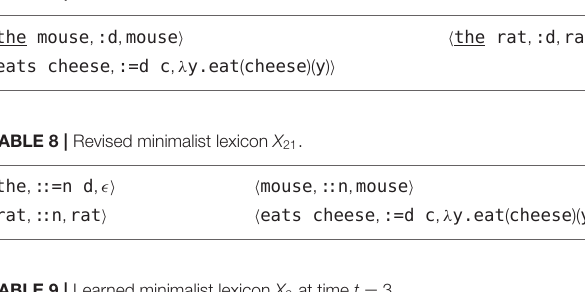
TABLE 7 | Learned minimalist lexicon X 2 at time t = 2.